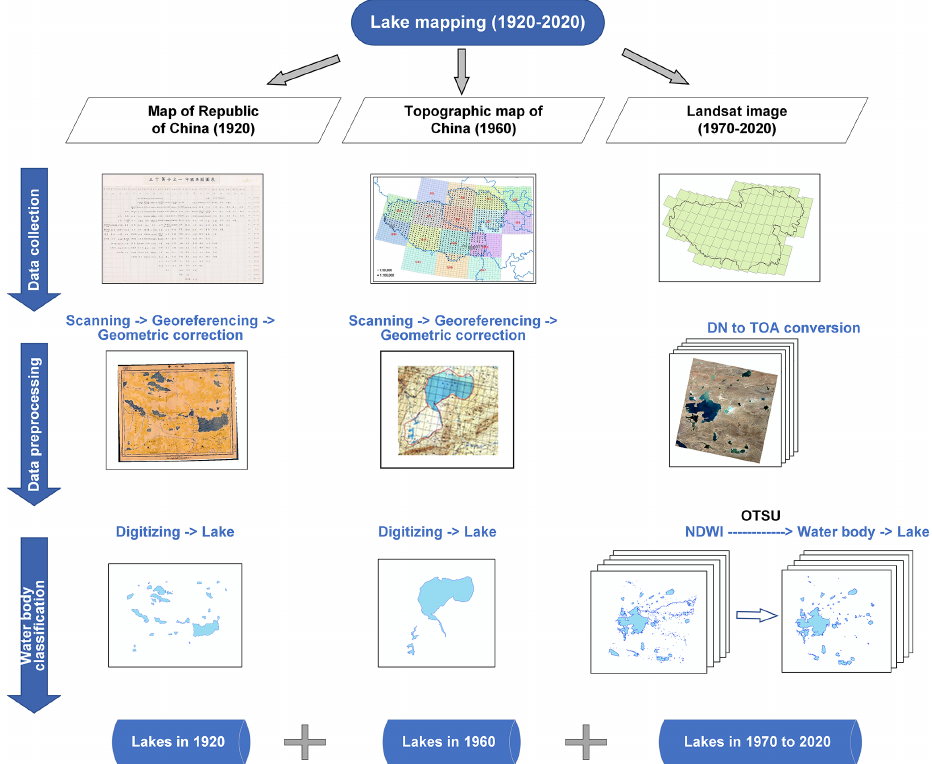
Figure 2. Flowchart showing the process for lake mapping of the QTP from 1920 to 2020. Three key steps: data collection, data preprocess- ing, and water body classification for maps of the early Republic of China in 1920, topographic map of China in 1960, and Landsat images in 1970–2020 are shown. The distribution of topographic maps over the QTP is from Wan et al.